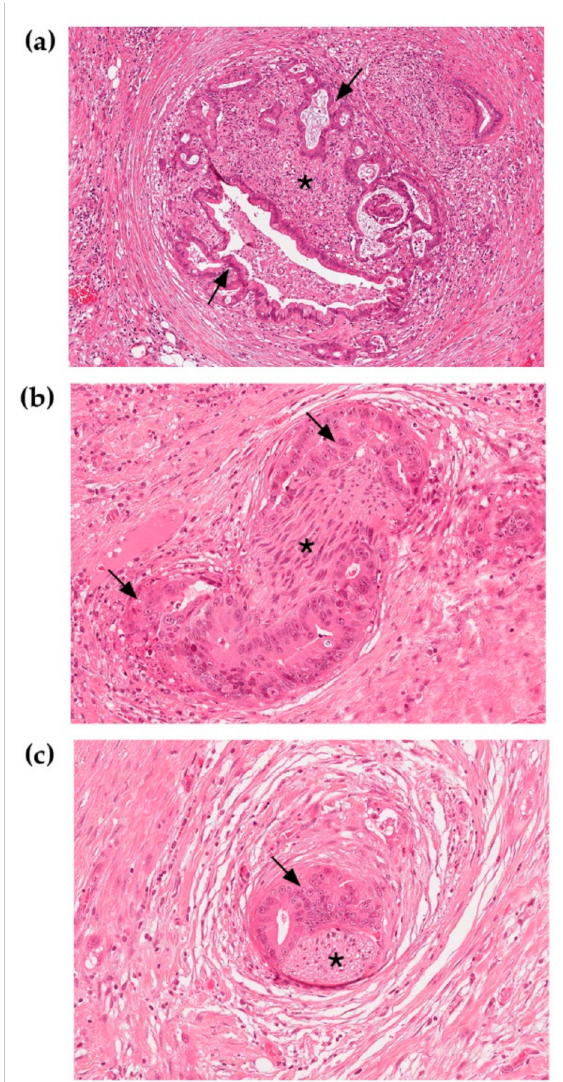
Figure 1. Nerves invaded by pancreatic ductal cancer stained with Hematoxylin and Eosin. ( a ) Neoplastic glands are growing around and within the nerve fiber. ( b , c ) Small diameter nerve fibers surrounded by neoplastic glands. 20 × Magnification. Arrows indicate neoplastic glands; asterisks point to nerve